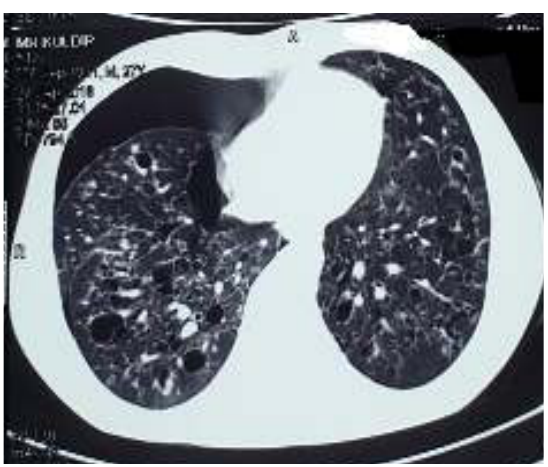
Figure 2: Computed tomography (CT) with a bilateral cystic lesions Bronchoscopy was